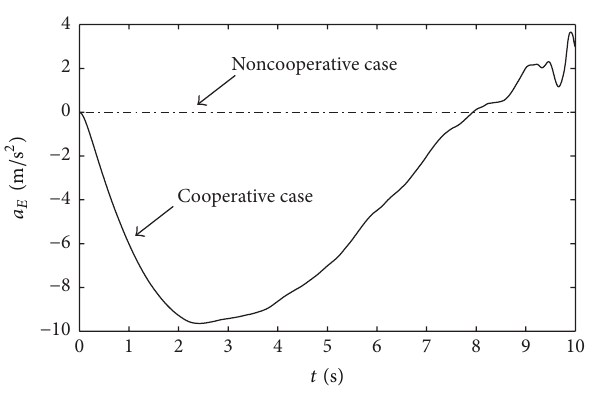
Figure 12: The trajectories of the cooperative case considering HP guidance